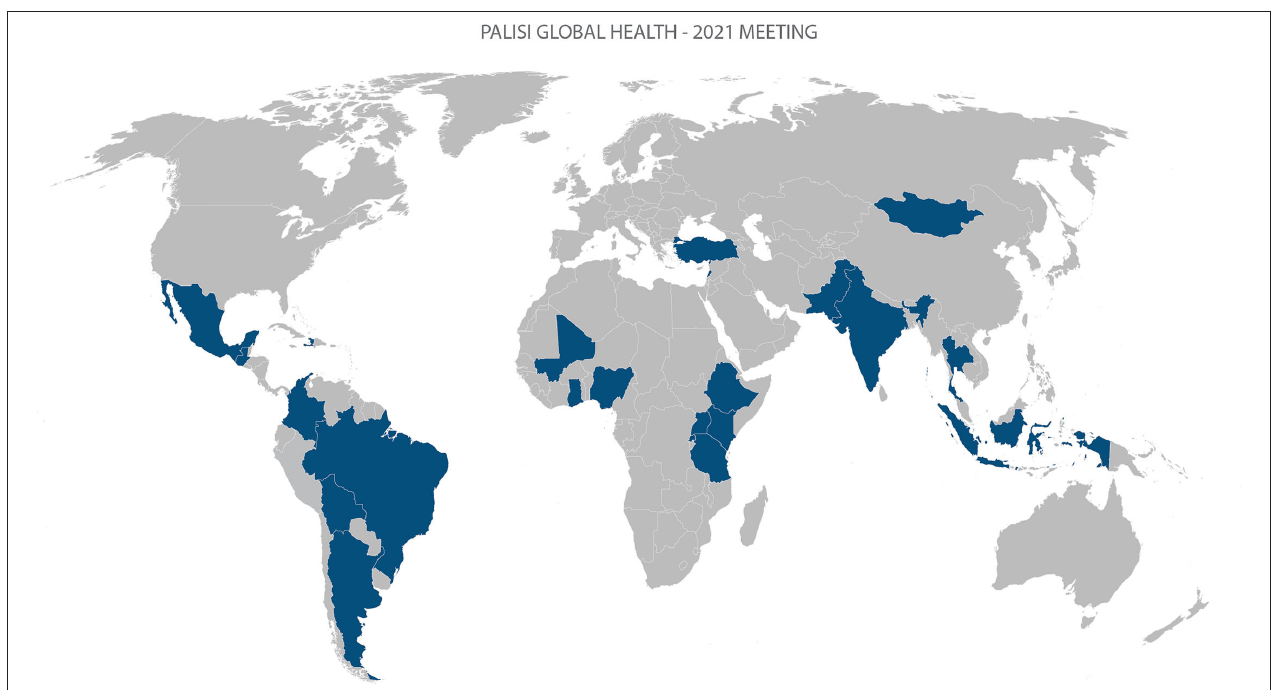
FIGURE 1 | World map of participating